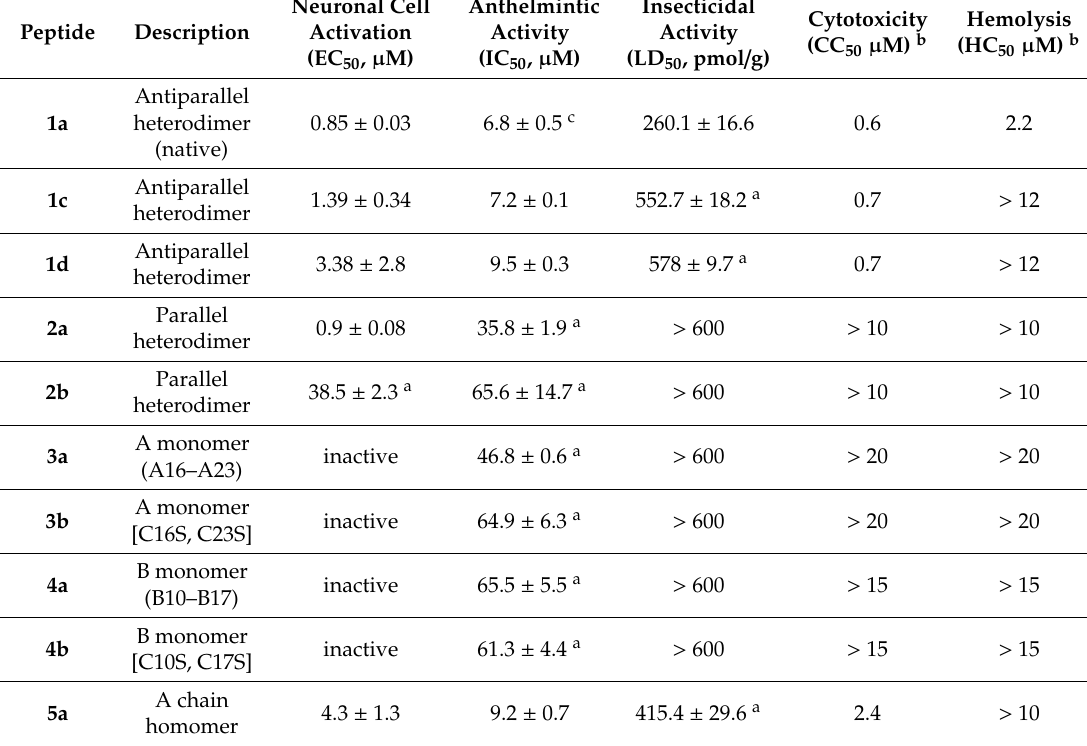
Table 2. Summary of bioassay data for synthetic Mp1a and analogues, including e ff ective concentration (EC 50 ) for activation of F11 cells, concentrations that caused 50% inhibition (IC50) for inhibition of larval development of H. contortus ; median lethal dose (LD 50 ) for lethal insecticidal e ff ects on D. melanogaster ; concentrations required to induce 50% cell death (CC 50 ) for e ff ects on viability of HEK293 cells, and concentrations required to lyse 50% of the red blood cells (HC 50 ) for lysis of human red blood cells. All errors are